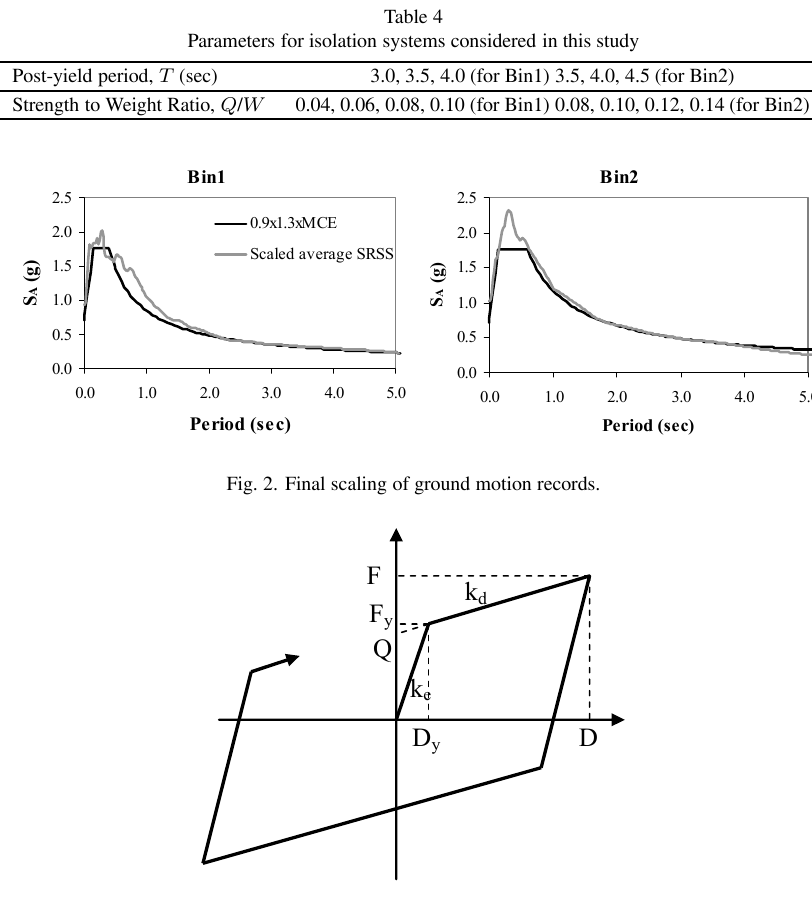
Fig. 3. Bi-linear force-deformation relation of an